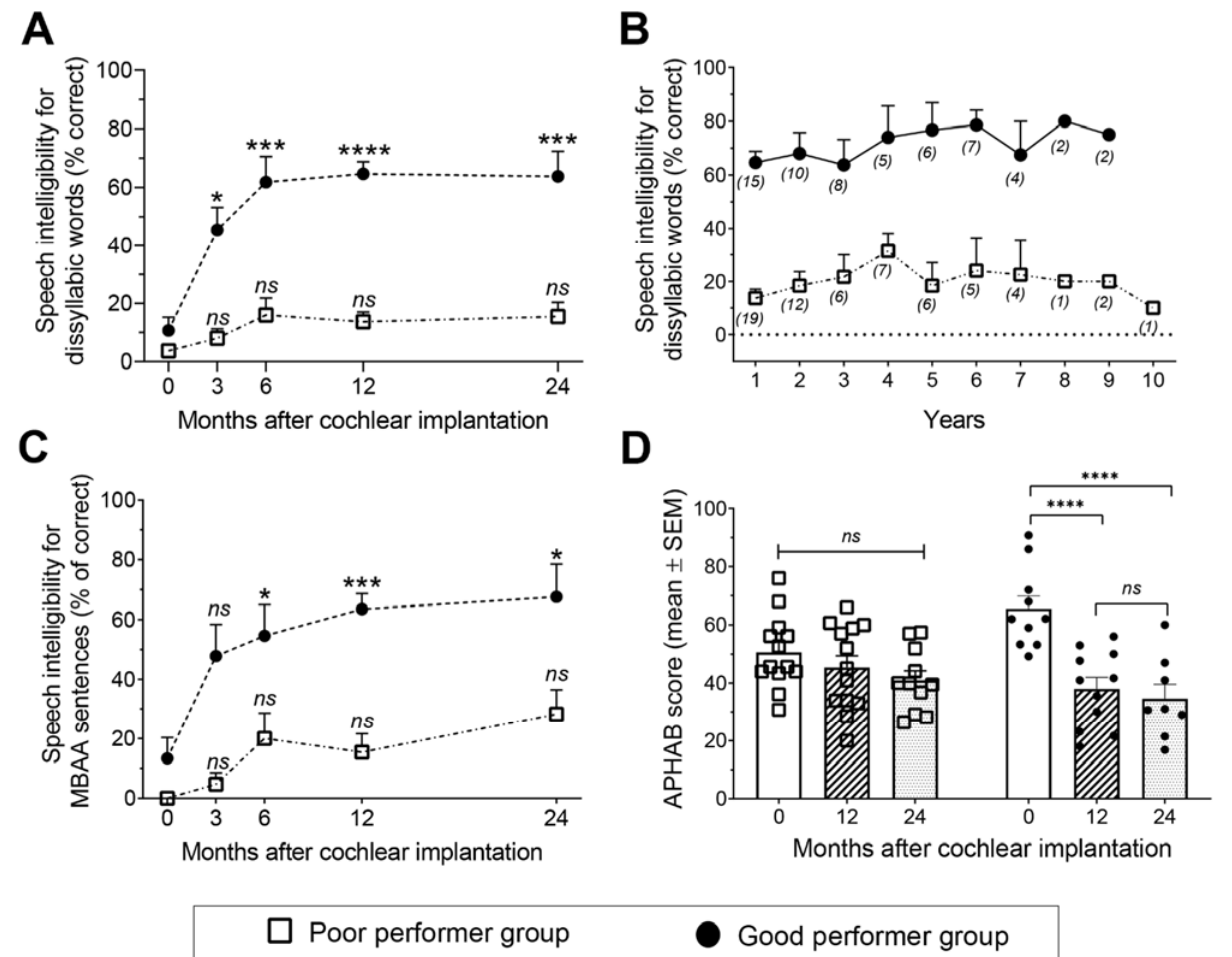
Figure 2. Post-operative evolution after cochlear implantation. ( A ) Speech intelligibility without lipreading for disyllabic words in silence in the 2 groups. Compared to the preoperative scores, an improvement was observed for the good performer group at 3 months ( p = 0.015), 6 months ( p = 0.0002), 1 year ( p < 0.0001), and 2 years ( p = 0.0005) post-implantation. For the poor performer group, no significant improvement was found. n = 15, 11, 11, 15, 8 for the good performer group, and 19, 10, 10, 19, 11 for the poor performer group, respectively at 0, 3, 6, 12, and 24 months after cochlear implantation. ( B ) Evolution of speech intelligibility for disyllabic words over time in the 2 groups. ( n ) are the number of patients at each time point. ( C ) Speech intelligibility without lipreading for MBAA sentences in the 2 groups. Compared to the preoperative scores, an improvement was observed for the good performer group at 6 months ( p = 0.024), 1 year ( p = 0.0007), and 2 years ( p = 0.011) post-implantation. For the poor performer group, no significant improvement was found. n = 12, 11, 10, 14, 7 for the good performer group, and 9, 7, 8, 13, 10 for the poor performer group, respectively at 0, 3, 6, 12, and 24 months after cochlear implantation. ( D ) Mean ± SEM of APHAB scores before, 1 and 2 years after implantation in the 2 groups, showing an improvement only for the good performer group ( p < 0.0001). APHAB, Abbreviated Profile of Hearing Aid Benefit. Data are mean ± SEM; a two-way ANOVA with a Tukey multiple comparisons test was performed for statistical analysis. * p < 0.05; *** p < 0.0005, **** p < 0.0001, ns : non